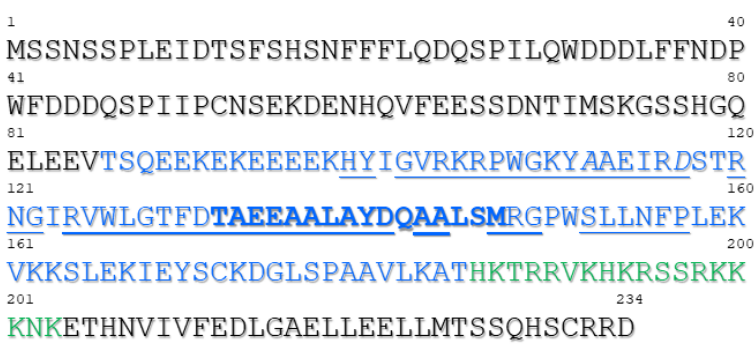
Figure 8. Amino acid sequence of tobacco SHE1, with proposed functional domains indicated. The SHE1–IVR binding region (amino acids 86-185) is shown in blue letters. Identical or highly conserved amino acids between AP2/ERFs transcription factors (TFs) and related proteins, corresponding to DNA-binding domain found in AP2/ERF TFs, are underlined (amino acids 99–157). Italicized blue residues (A112 and D117) are required for GCC binding. An amphipathic α -helix at amino acids 132–147 is shown in bold blue. The basic region at amino acids 186–203 is a proposed nuclear localization signal, shown in green. The amino acids at the N and C termini resemble those shown to be involved in transcription activation. The N and C termini are both acidic.